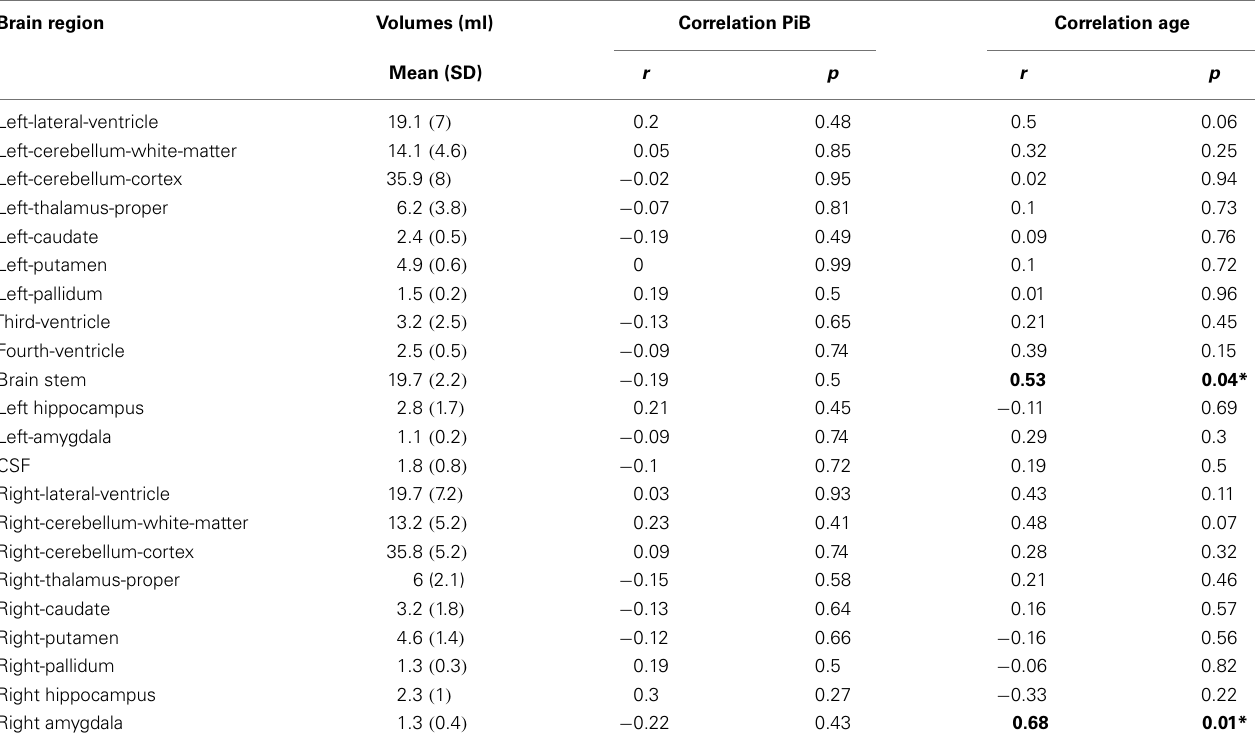
Table 2 |Volumes of brain structures as derived from the 7-TT1 MPRAGE images